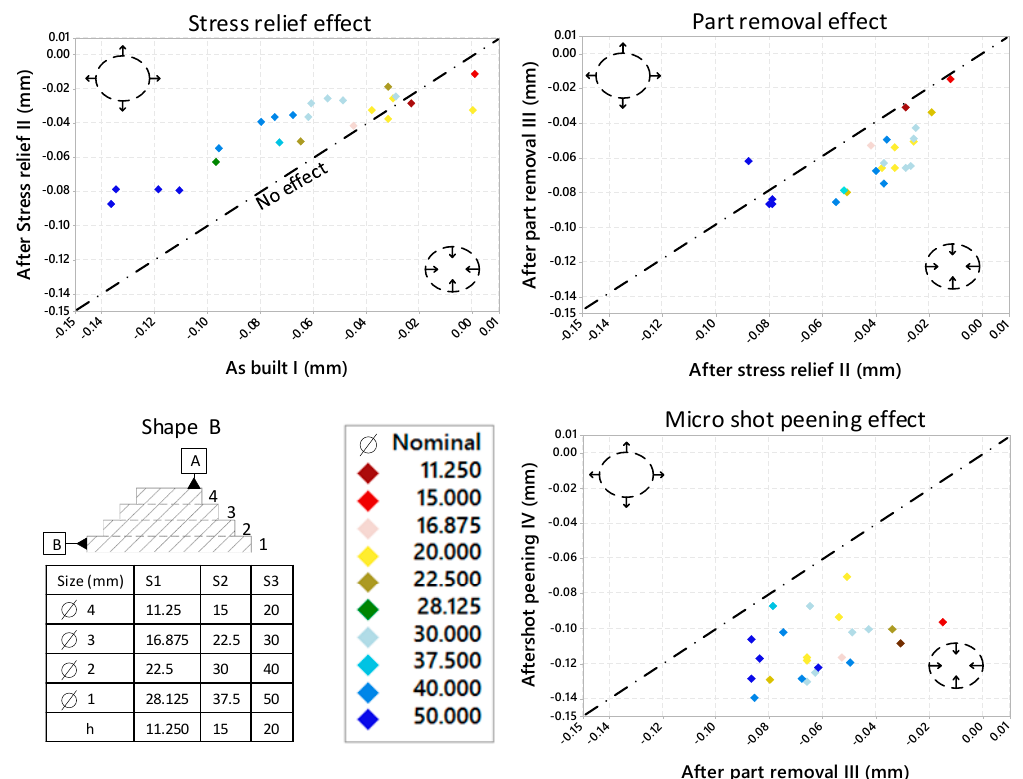
Figure 13. Post-processing step effects on the external diameter of 12 Shape B artifacts .